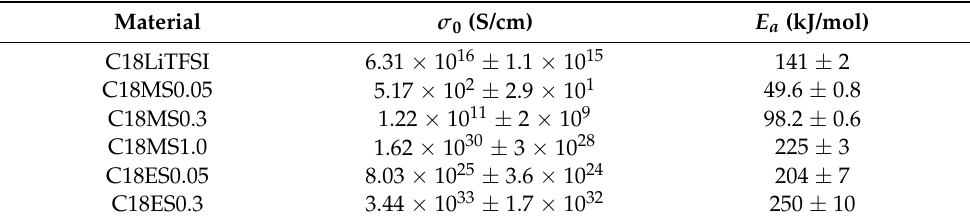
Table 6. Values of σ 0 (S/cm) and E a (J) obtained from the Arrhenius fits of conductivity for several electrolyte